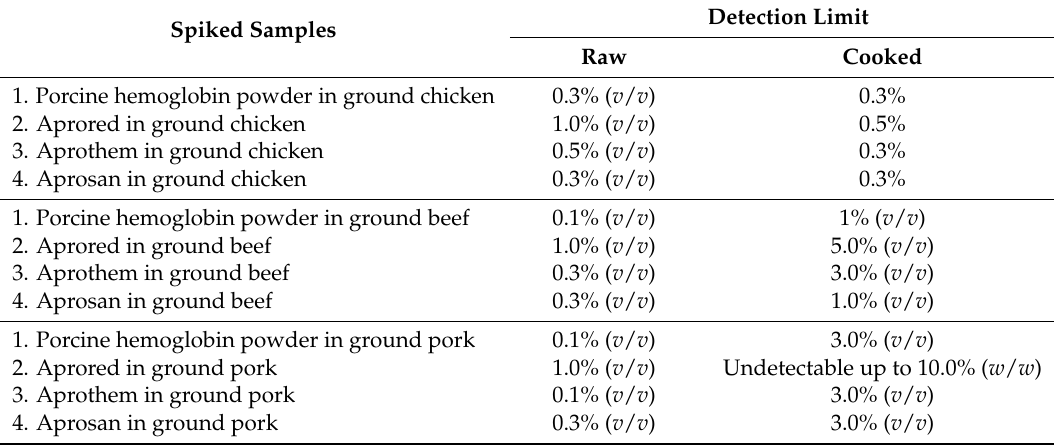
Table 2. Summary of detection limit of spiked meat samples using 24C12-E7 based